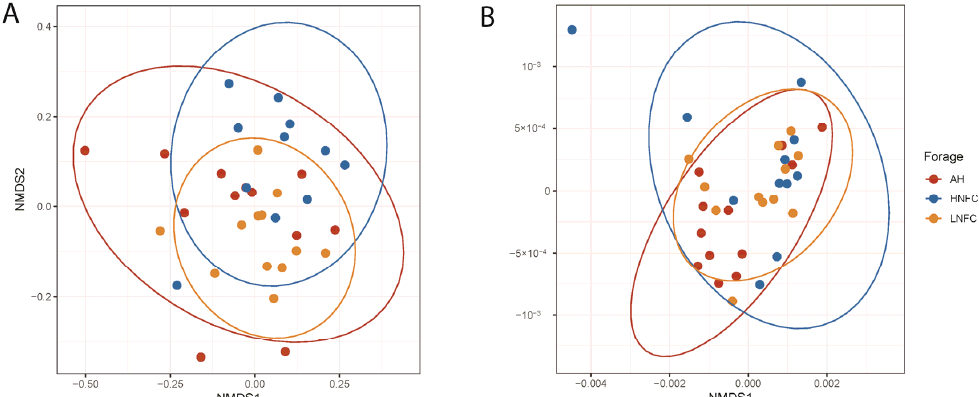
Figure 1. NMDS of beta-diversity calculated based on ( A ) Bray–Curtis dissimilarity and ( B ) weighted unifrac distance. Samples were obtained from different dietary treatments and are indicated with differently shaped symbols and colors. The colored ellipses are described by a 95% confidence interval.